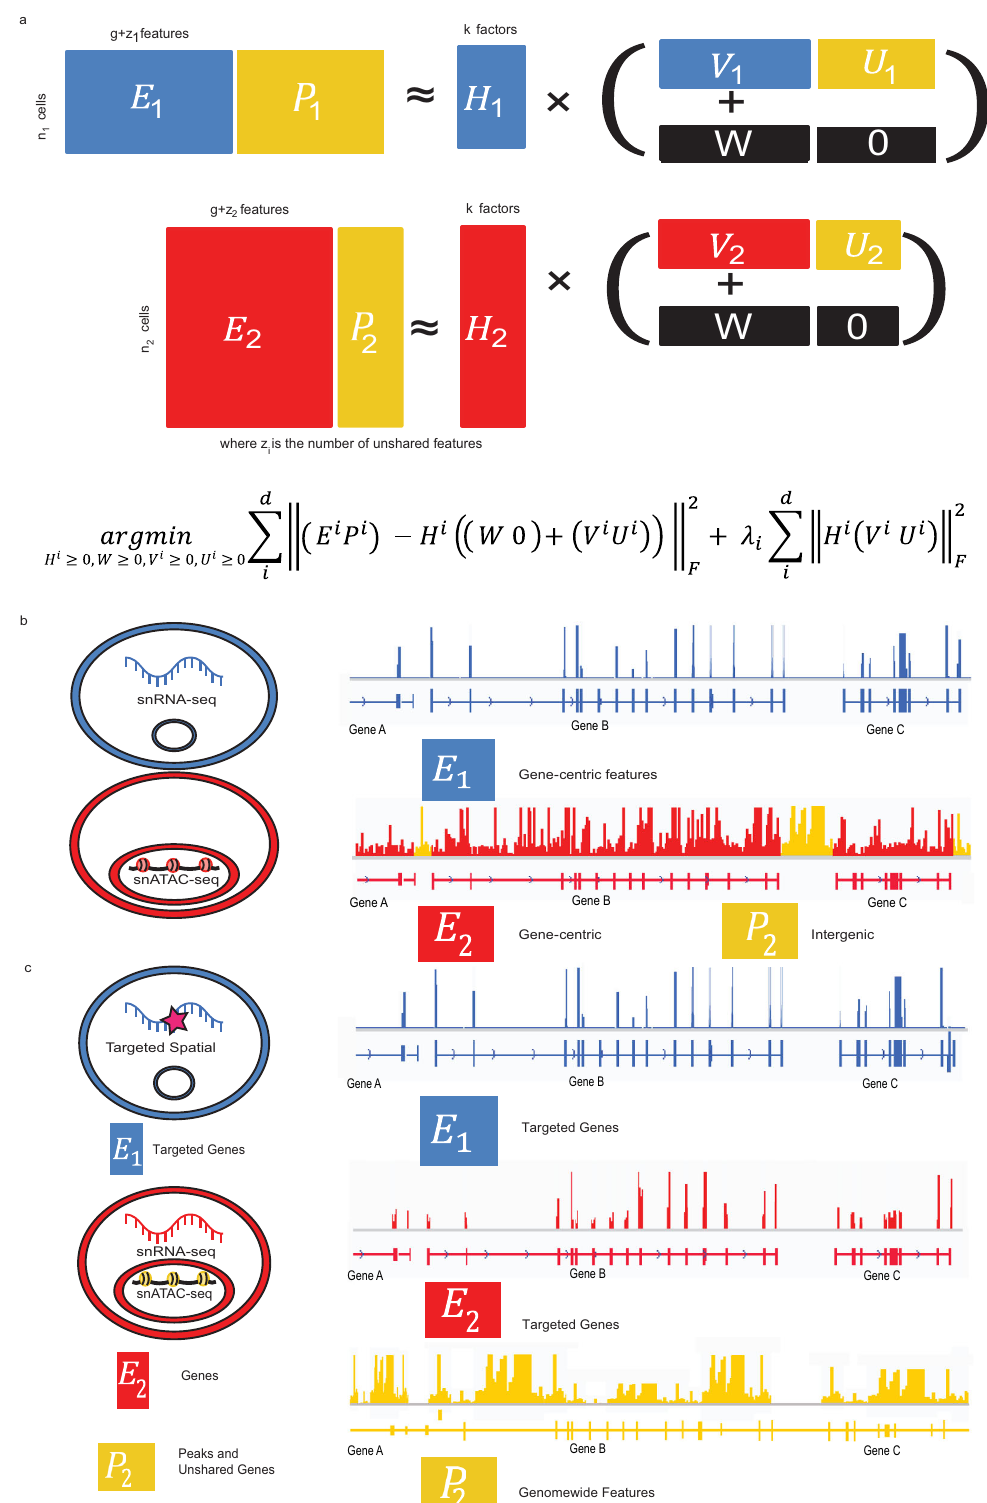
Fig. 1 Overview of the UINMF algorithm for integrating single-cell datasets with partially overlapping features. a Schematic representation of the matrix factorization strategy (top) and optimization problem formulation (bottom). The addition of a factor matrix U i allows for unshared features to be utilized in joint matrix factorization. Each dataset ( E i ) is decomposed into shared metagenes ( W ), dataset-speci fi c metagenes constructed from shared features ( V i ), unshared metagenes ( U i ), and cell factor loadings ( H i ). The incorporation of the U matrix allows unshared features that occur in only one dataset to inform the resulting integration. b UINMF can integrate data types such as scRNA-seq and snATAC-seq using both gene-centric features and intergenic information. c UINMF can integrate targeted spatial transcriptomic data with simultaneous single-cell RNA and chromatin accessibility measurements using both unshared epigenomic information and unshared